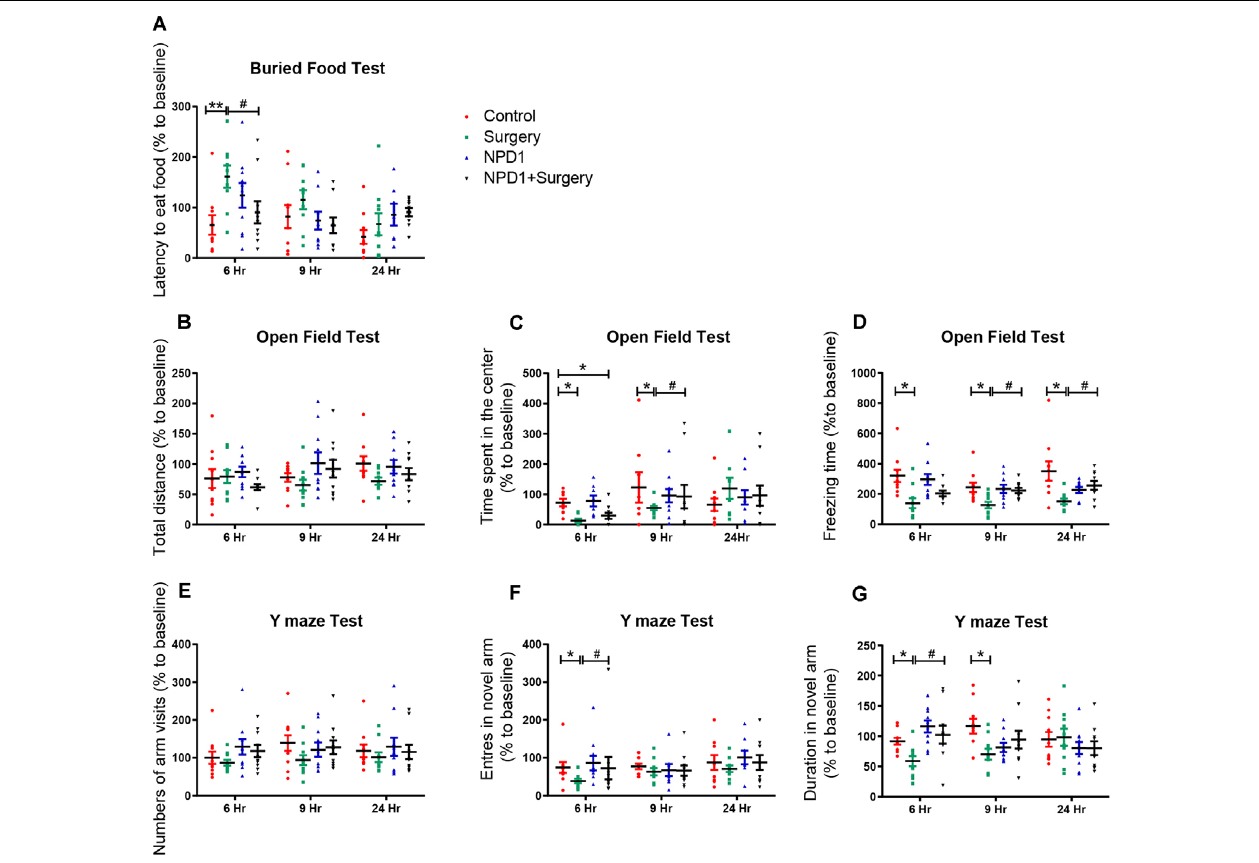
FIGURE 1 | Surgery/anesthesia induces postoperative delirium (POD)-like behavior of aged mice, which can be ameliorated by preemptive administration of neuroprotectin D1 (NPD1). At 6, 9, and 24 h after surgery/anesthesia, the buried food test (A) , open field test (B–D) , and Y maze test (E–G) were executed ordinally. Data are presented as individuals and the lines mark the mean ± standard error of the mean (SEM). Statistics: two-way analysis of variance (ANOVA) followed by Bonferroni post hoc comparison. (A–G) n = 8–10 per group. * P < 0.05 vs. the control group, ** P < 0.01 vs. the control group, # P < 0.05 vs. the surgery